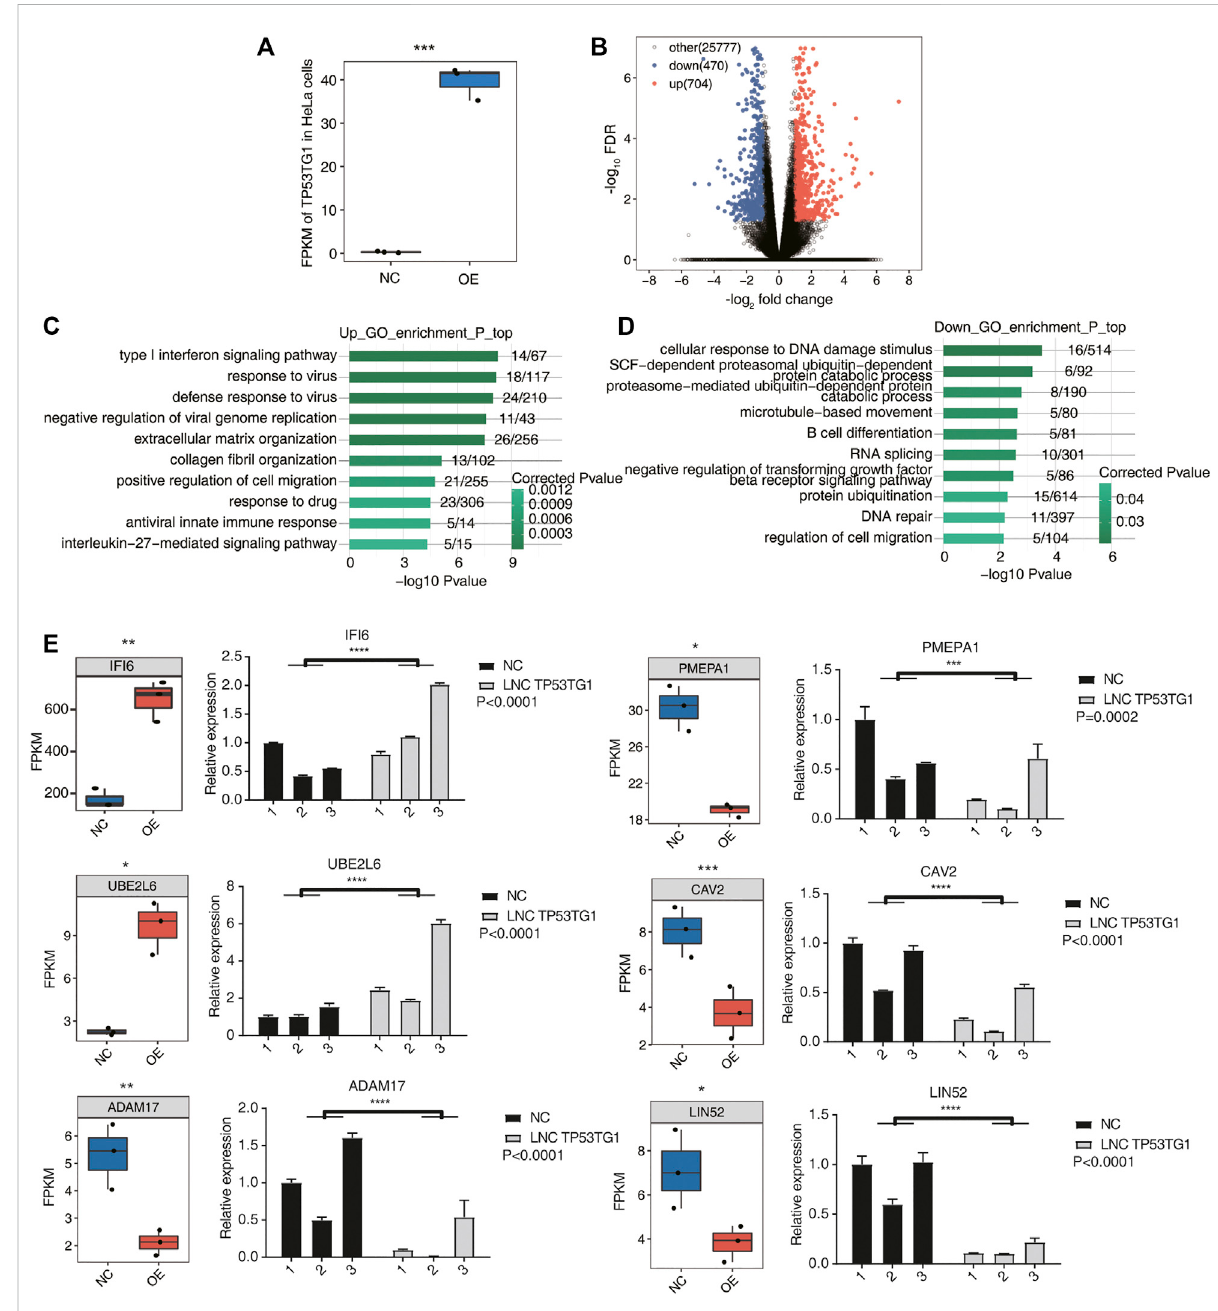
FIGURE 3 TP53TG1 regulates the expression of genes involved in type I interferon signaling pathways and DNA damage responses. (A) Boxplot showing the expression pattern of TP53TG1 in TP53TG1-overexpressing (TP53TG1-OE) HeLa cells and controls. (B) Volcano plot presenting the differences between TP53TG1-OE and NC groups. The results showed the number of differences between TP53TG1-OE group and control group (FC ≥ 2 or ≤ 0.5 and FDR ≤ 0.05. (C,D) The bar plot exhibiting the most enriched GO biological process results of the upregulated (C) and downregulated (D) DEGs. (E) Expression pro fi le of DEGs regulated by TP53TG1 in RNA-seq along with in reverse transcription-qPCR validation in HeLa cells. Black bars represent the control group and grey bars represent TP53TG1 overexpression. *** p <